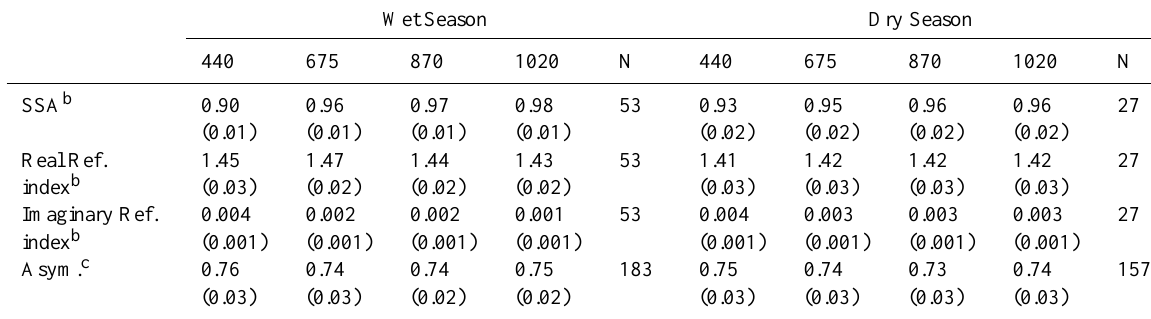
Table 6. Seasonal means (dimensionless) of SSA, real and imaginary parts of the refractive index (Ref. index), and asymmetry parameter (Asym.) at 440, 675, 870 and 1020nm a . Number of daily available observations (N) is also indicated.